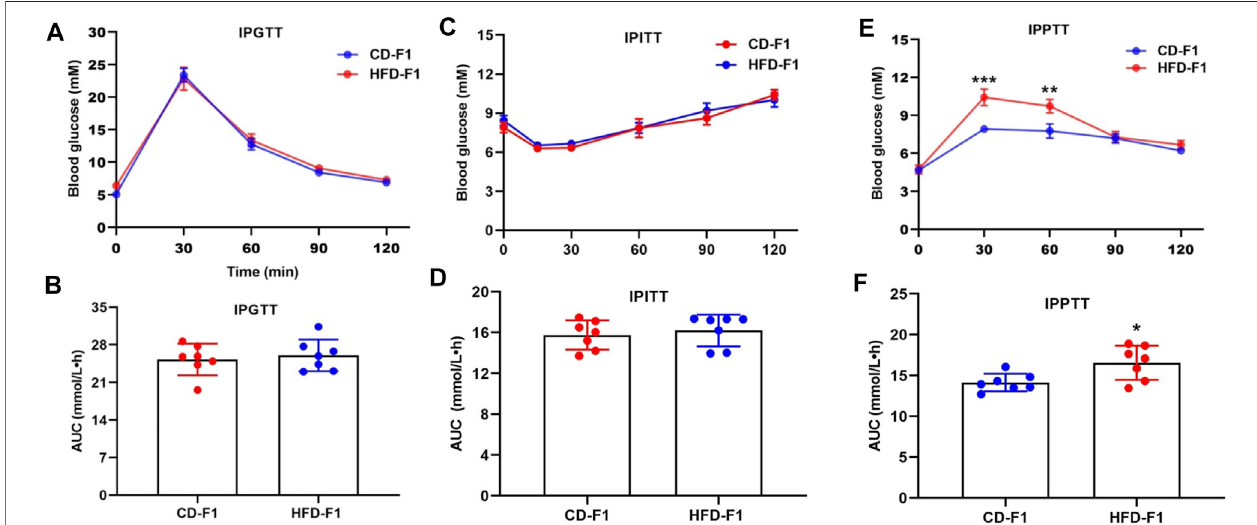
FIGURE1 | Paternalhigh-fat diet leads togluconeogenesis alteration inoffspring. (A , B) Glucose tolerance test (2 g/kg body weight) and AUCof 11-week-old CD- F1 ( n = 7) and HFD-F1 ( n = 7) male mice. (C , D) Insulin tolerance test (1 IU/kg body weight) and AUC of 12-week-old CD-F1 ( n = 7) and HFD-F1 ( n = 7) male mice. (E , F) Pyruvate tolerance test (2 g/kg body weight) and AUC of 13-week-old CD-F1 ( n = 7) and HFD-F1 ( n = 7) male mice. * p < 0.05, ** p < 0.01, *** p <